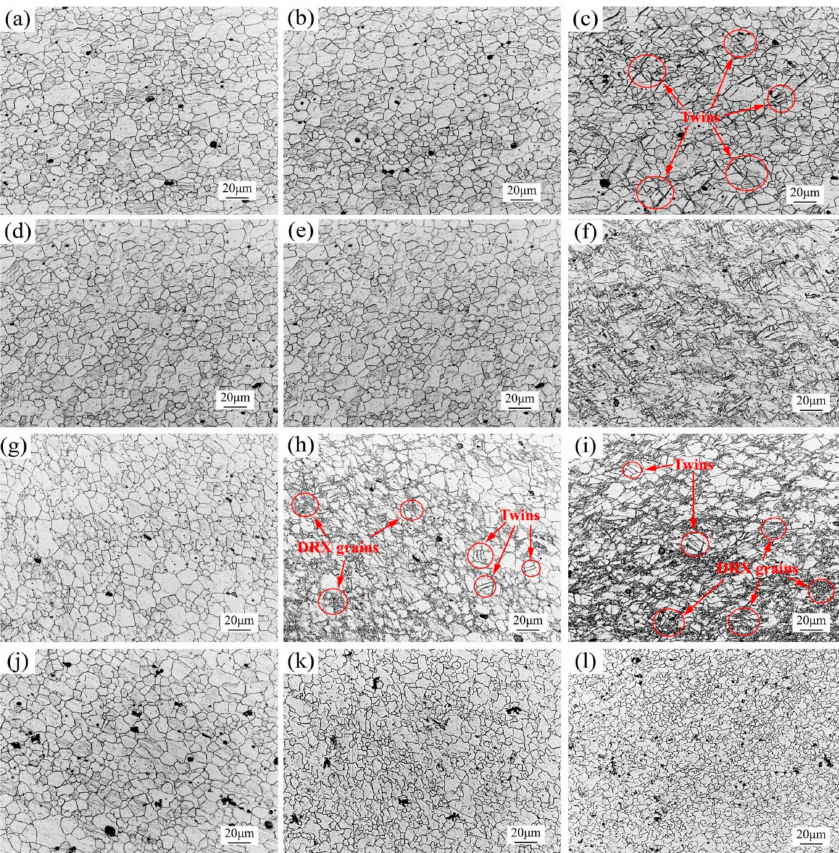
Figure 10. Microstructures in the transverse section of different regions at different temperatures: ( a – c ) R1–R3 zone at 20 ◦ C, ( d – f ) R1–R3 zone at 150 ◦ C, ( g – i ) R1–R3 zone at 250 ◦ C and ( j – l ) R1–R3 zone at 300 ◦